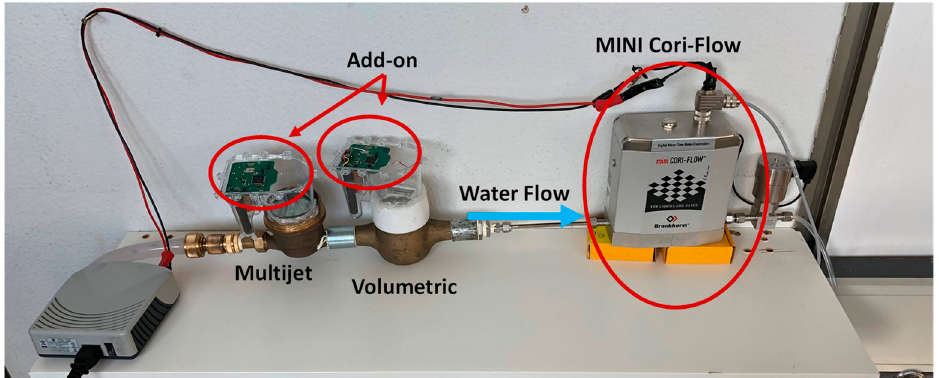
Figure 3. The test rig developed. Table 1. Technical specification MINI CORI-FLOW™ M15. Table 1. Technical specification MINI CORI-FLOW™ M15. Flow range (intermediate ranges